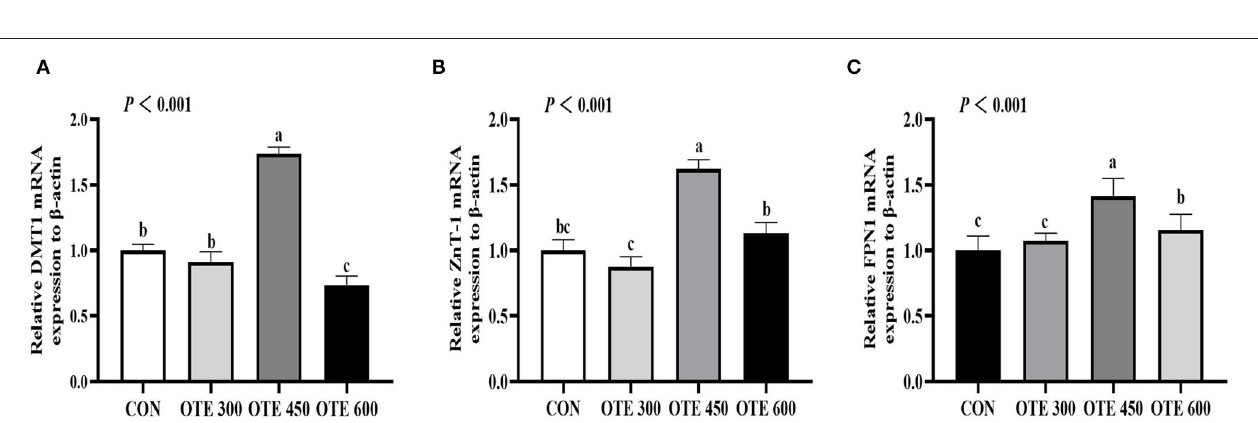
FIGURE 4 | Effects of organic trace elements supplementation on ferroportin 1 (FPN1) localization in the duodenum of late-phase laying hens. (A–D) Represent the control, 300, 450, and 600 mg/kg organic trace elements, respectively. Scale bars were 100 µ m (A1–D1) and 20 µ m (A2–D2,A3–D3) . The red arrow represents FPN1 immunopositive cells in the duodenal villi, and the black arrow represents FPN1 immunopositive cells in the duodenal gland ( n = 6).